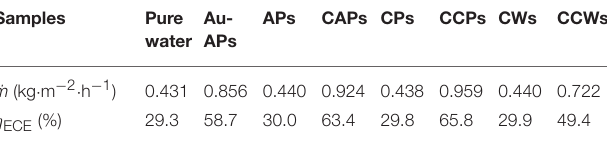
TABLE 1 | The water evaporation rates ( ˙m ) of various samples and the calculation results of the energy conversion efficiency ( η ECE ). Samples